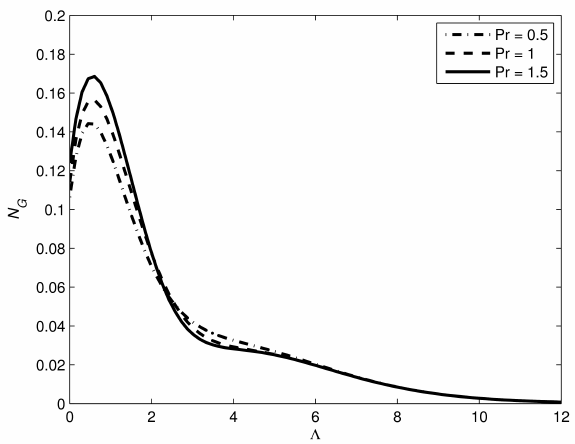
Figure 27: Effect of Pr on N G keeping ζ = η = 0.2 , C 1 = C 2 = C 3